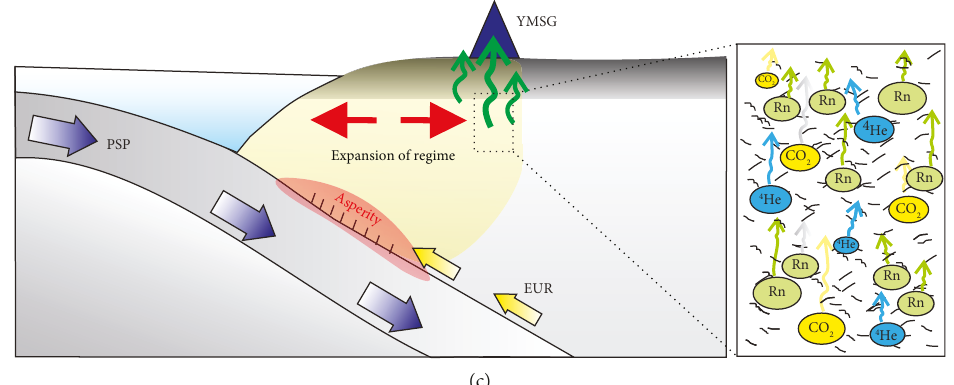
Figure 8: (a) A schematic diagram of the proposed physical mechanism based on the gamma ray anomaly of YMSG and radon anomaly at TPT. Stages 1 (b) and 2 (c) are considered to have occurred in order before the signi fi cant earthquakes. The schematic diagram showing a crustal-scale cross-section along the geophysical transect (AA ′ in (a)) modi fi ed by Fu et al. [41] is shown in